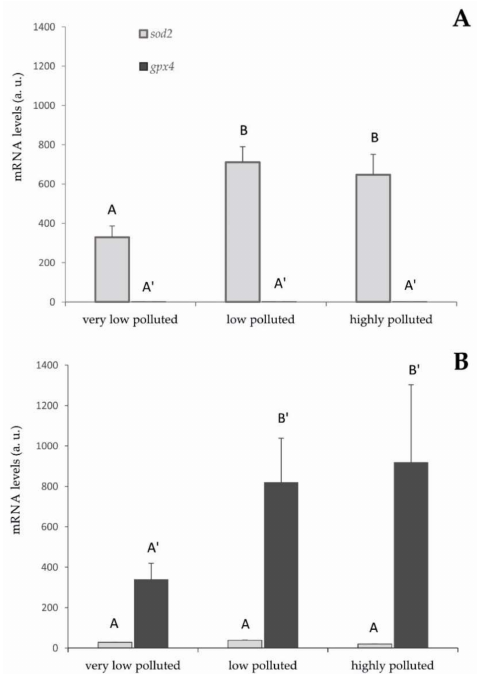
Figure 1. gpx4 and sod2 mRNA levels in ( A ) S. cephalus and ( B ) P. bonelli liver. Values (arbitrary units) are indicated as mean ± SD. Transcription levels were normalised to the gapdh housekeeping gene. Different letters correspond to significant statistical differences ( p < 0.05) among different sites (Student–Newman–Keuls test). Five specimens per site were singularly